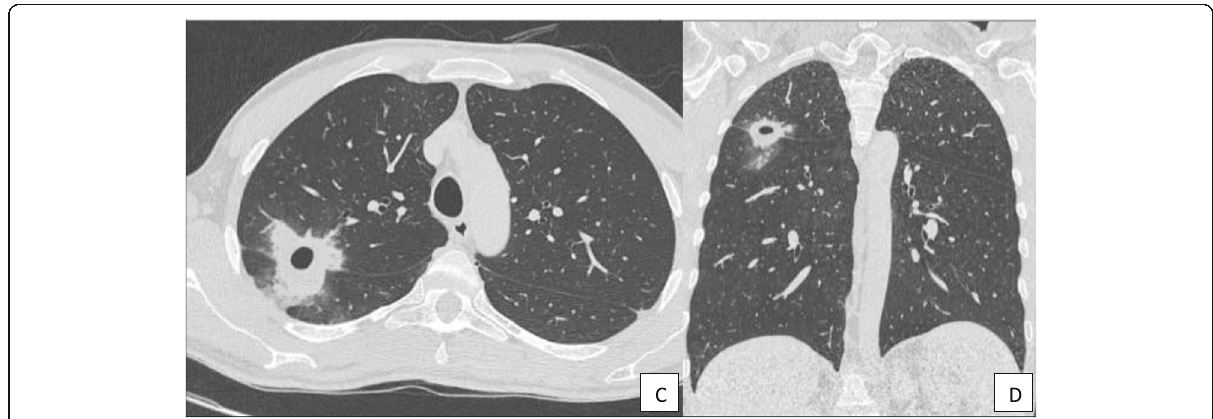
Fig. 2 Involvement of the right upper and inferior lung lobe shown in chest CT in transverse ( c ) and coronal view ( d